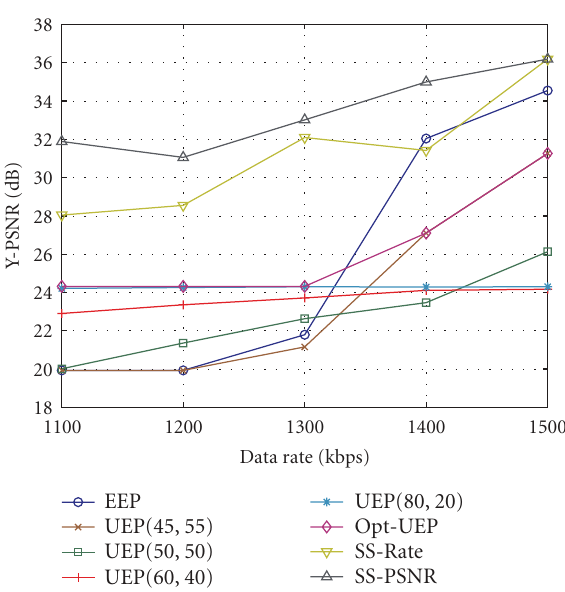
Figure 9: PSNR versus Data rate at PLR of 10% for the “Paris” sequence—uniform